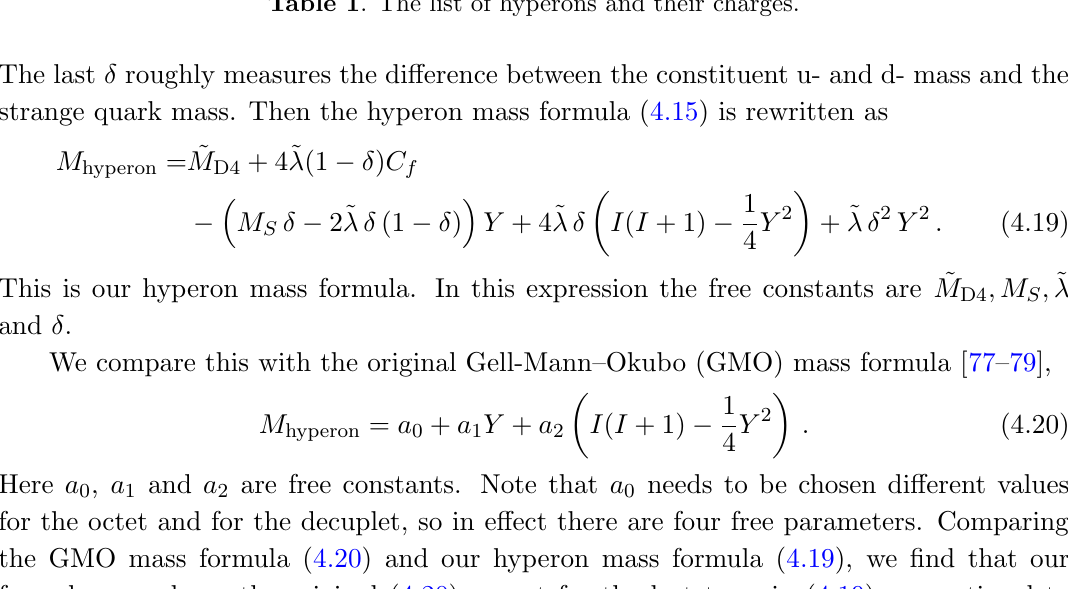
Table 1 . The list of hyperons and their